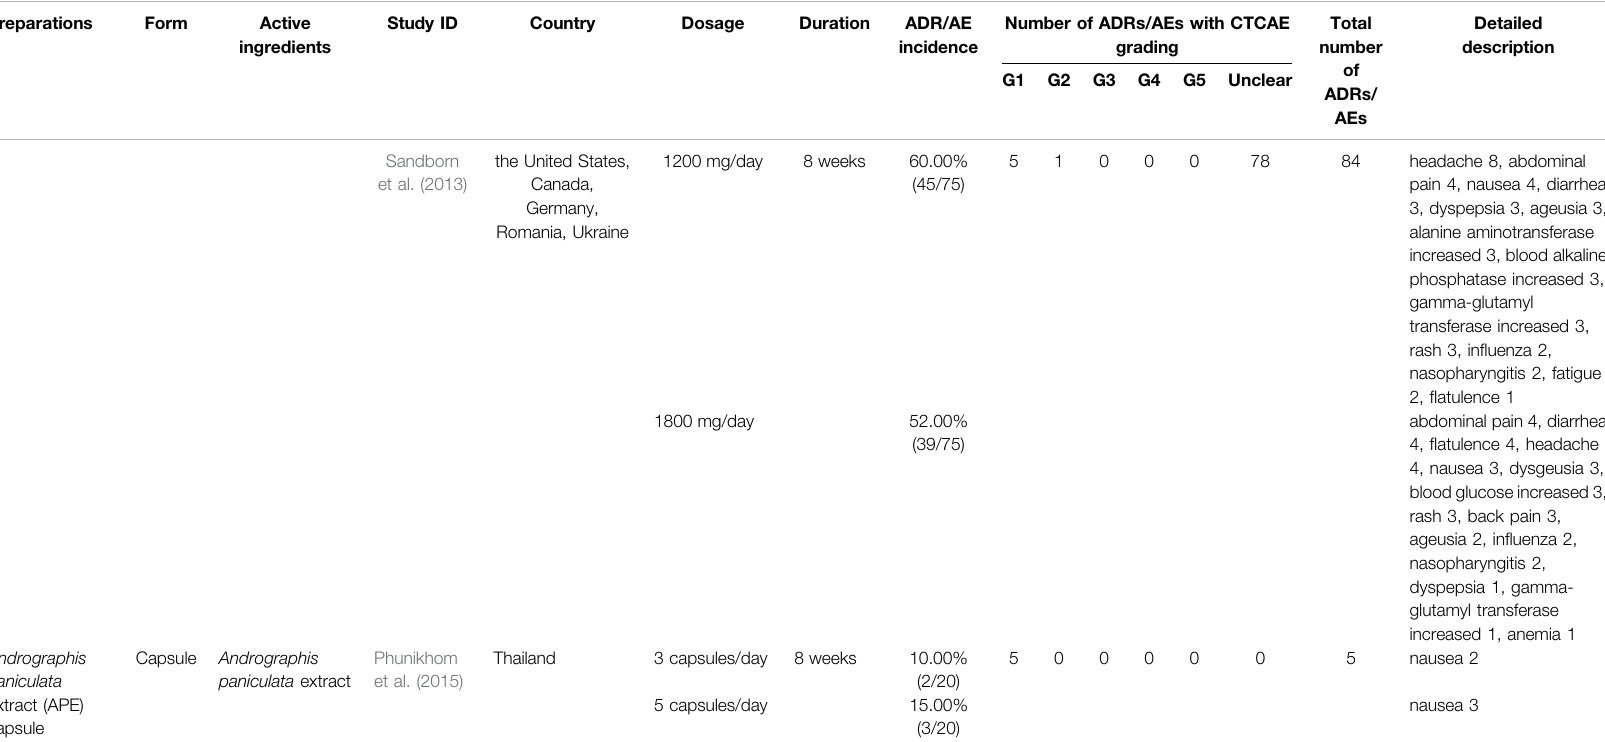
TABLE 6 | ( Continued ) Herbal preparations of Andrographis paniculata used in RCTs, non-RCTs, case series and their